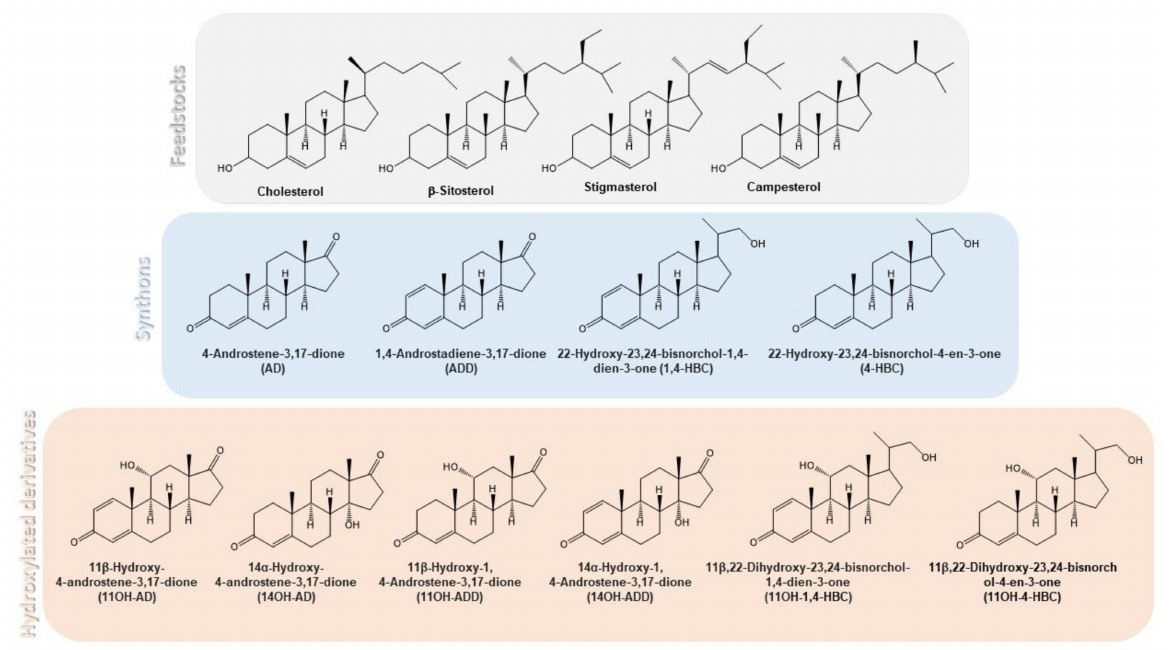
Figure 1. Chemical structure of the most relevant steroidal compounds described in this